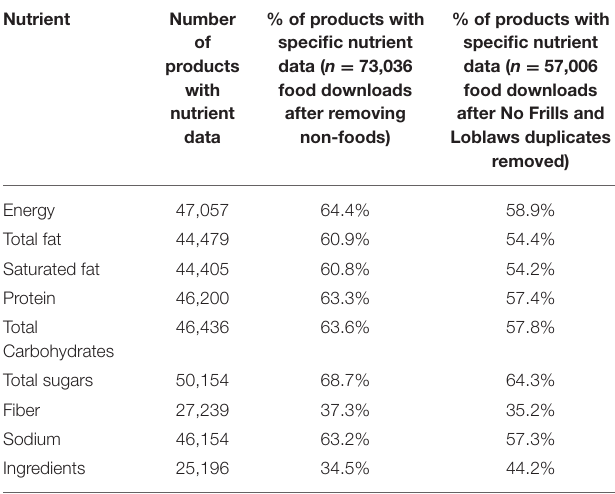
TABLE 3 | Frequency and percentage of occurrence of data for nutrients collected in FLIP 2020.